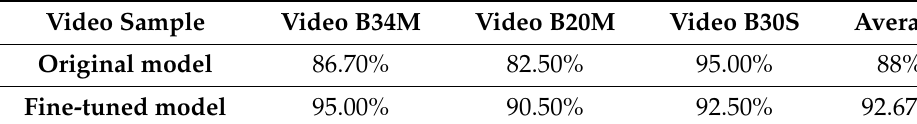
Table 3. Vehicle count-based queue length improvements.